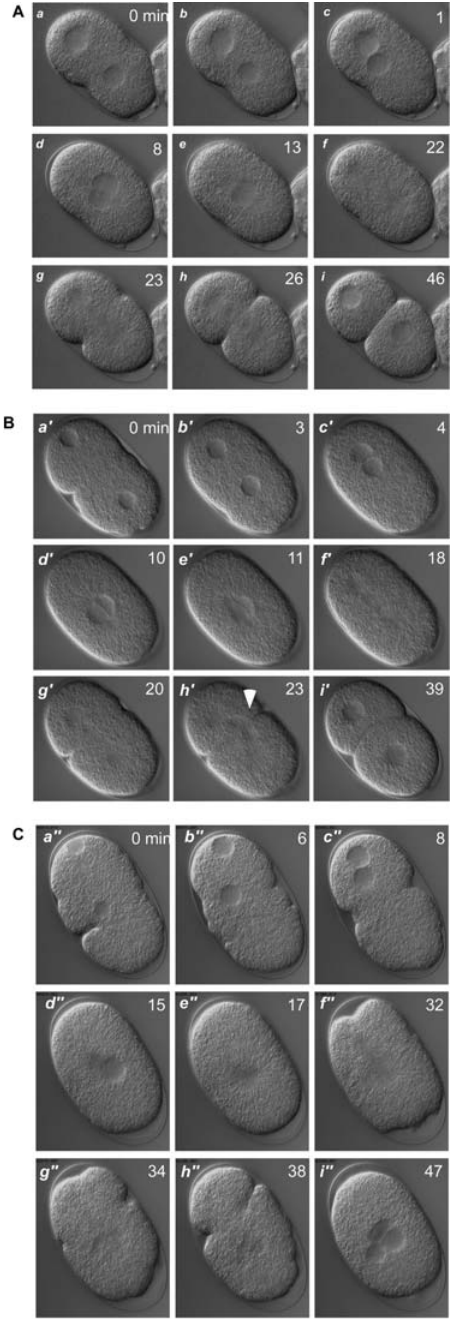
Figure 5. hcf-1 mutant embryos have cell-division defects. Excerpts from embryo movies (see Supporting Information). Embryos were prepared from adult hermaphrodites grown at 12 u C and kept at 12 u C during the observation. The lower right corresponds to the anterior pole of each embryo. The time in minutes is indicated at the top-right corner of each panel. (A) Wild-type embryo. Under these conditions, wild-type embryos undergo slow but normal cell division and develop into normal adults. a to c , pronuclear migration; d , pronuclear fusion and rotation; e , nuclear envelope breakdown; f , first mitotic spindle formed along the A-P axis; g and h , first cytokinesis; i , two-cell stage embryo. (B) pk924 embryo with subtle mitotic defect. Panels as in (A), note the abnormal cell division in panel h 9 (white solid arrow). (C) pk924 embryo with severe mitotic defect. Panels as in (A) except that panel f 0 displays an inappropriate spindle, panels g 0 and h 0 display failed cytokinesis, and panel i 0 displays the multinucleated single cell embryo product.